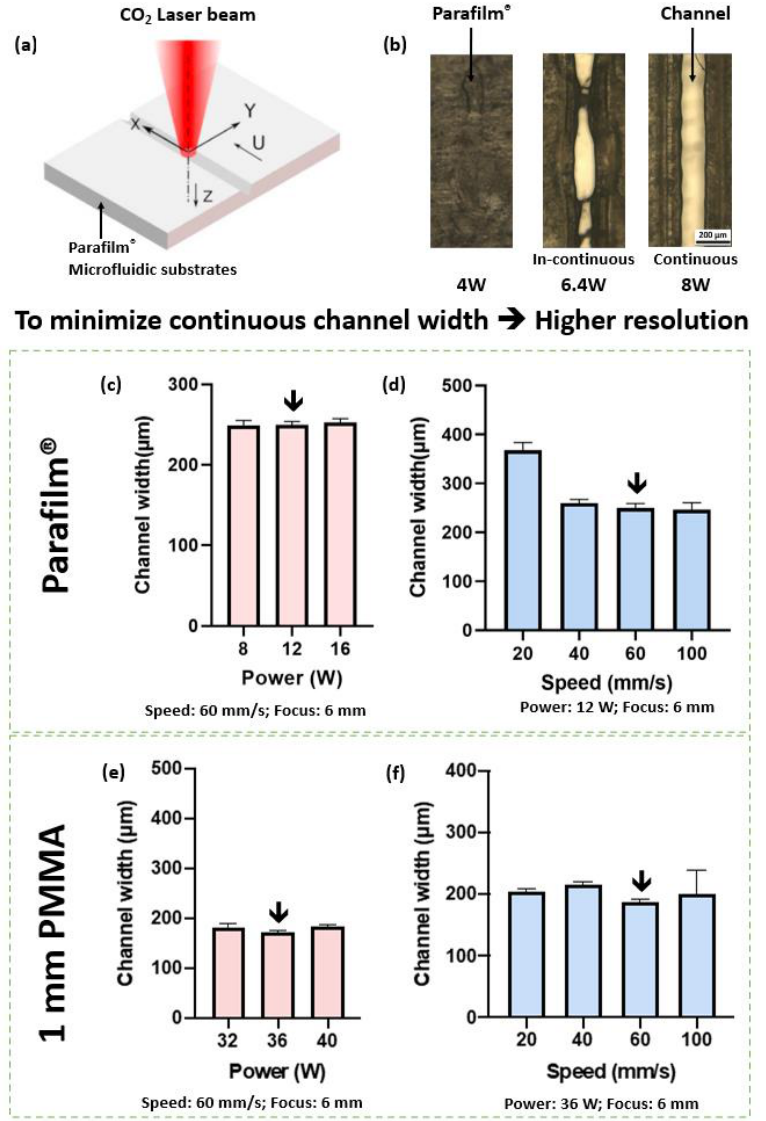
Figure 2. Illustration of laser ablation process ( a ) and effects of laser ablation parameters on the geometry of laser-plotted pattern ( b – f ). Optimized parameters were initiated. The optimization of laser output power and laser head speed was carried out with a focus of 6.0 mm. For each data point in figures ( c – f ), the experiment was carried out 5 times. ( a ) By laser ablation, Parafilm ® and different substrates were cut to desired patterns. ( b ) Laser output power was set to over 8.0 W to obtain a continuous channel when cutting Parafilm ® . ( c ) Laser output power vs. channel width for cutting Parafilm ® with laser head speed of 60 mm/s. ( d ) Laser head speed vs. channel width for cutting Parafilm ® with laser output power of 12.0 W. ( e ) Laser power vs. channel width for cutting 1 mm PMMA with laser head speed of 60 mm/s. ( f ) Laser head moving speed vs. channel width for 1 mm PMMA with laser output power of 36.0 W.